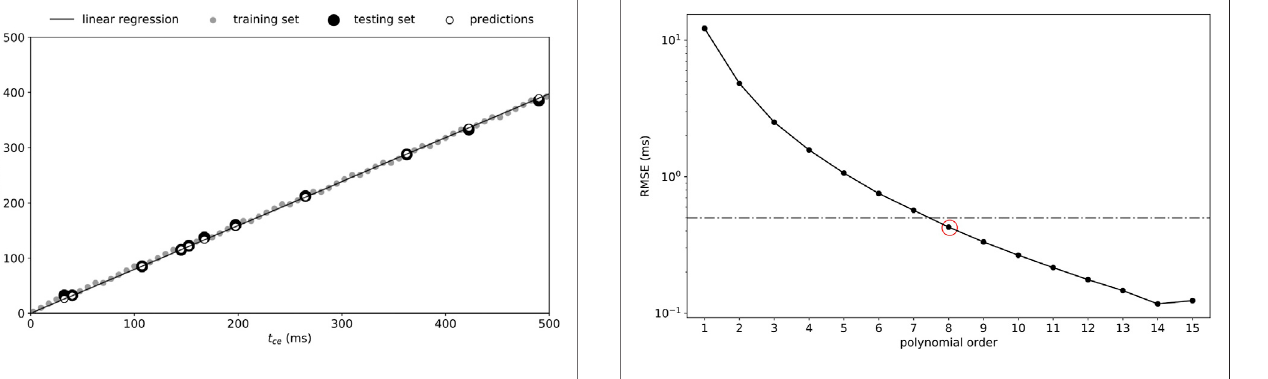
FIGURE 4 | Root-mean-square error (RMSE) computed on the testing set (15% points) for polynomial fi ts of order 1 to 15 performed on the training set (85% points). The red circle denotes the fi nal model of choice, an eighth- order polynomial model (RMSE (cid:2) 0.43 ms; R 2 (cid:2) 99 . 99%), and the gray line depicts the RMSE threshold of 0.5